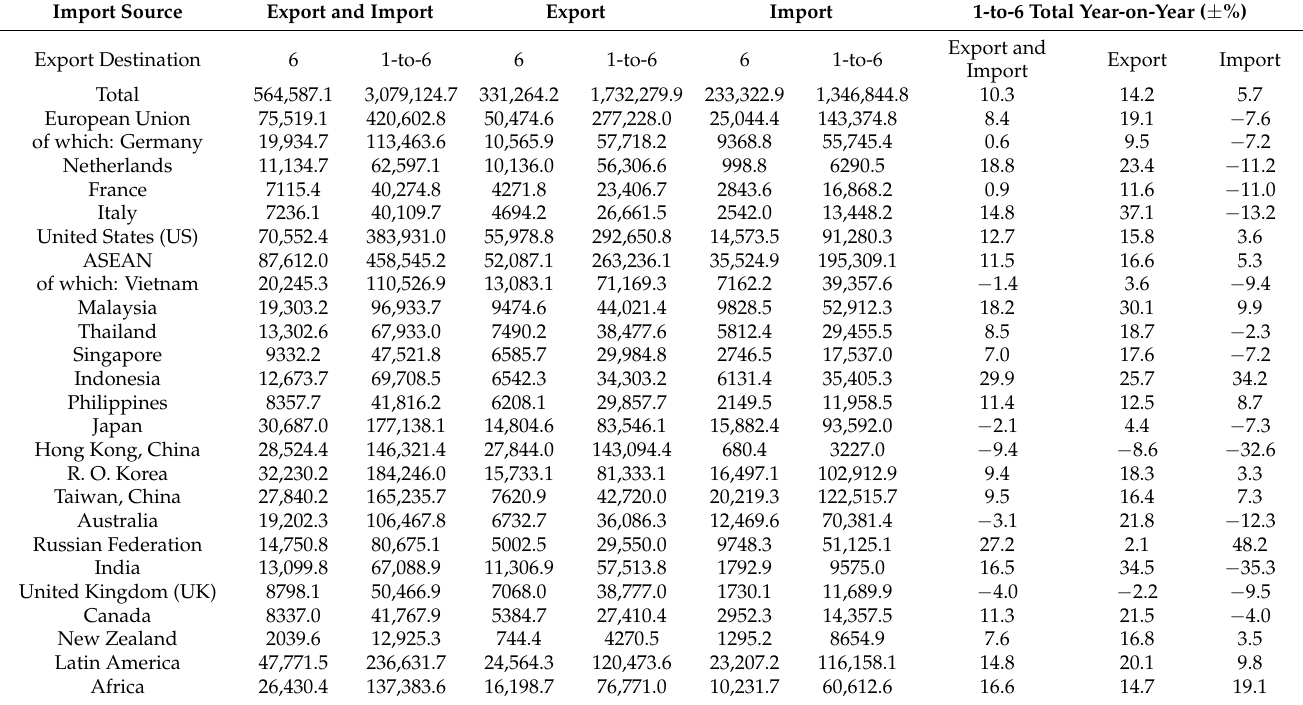
Table 7. China’s Total Export and Import Values by Country/Region, June 2022, millions USD